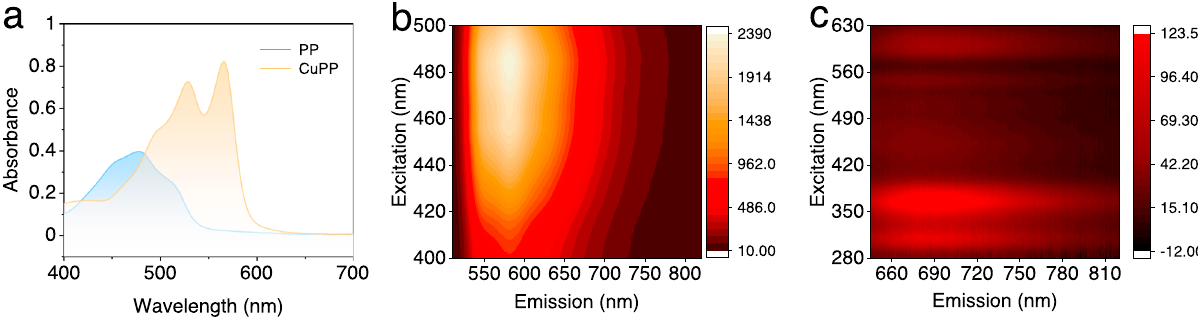
Fig. 3 Absorption and emission pro fi les of CuPP and PP. a UV – vis analysis of CuPP (20 μ M, orange) and purpurin (40 μ M, blue) in DMF; excitation and emission spectra of PP ( b ) and CuPP ( c ) at different wavelengths at 298 K in DMF. Source data are provided as a Source Data fi